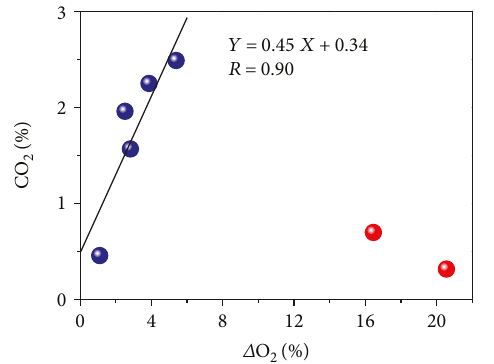
Figure 10: Relationship between depleted O (compared to atmosphere) and CO